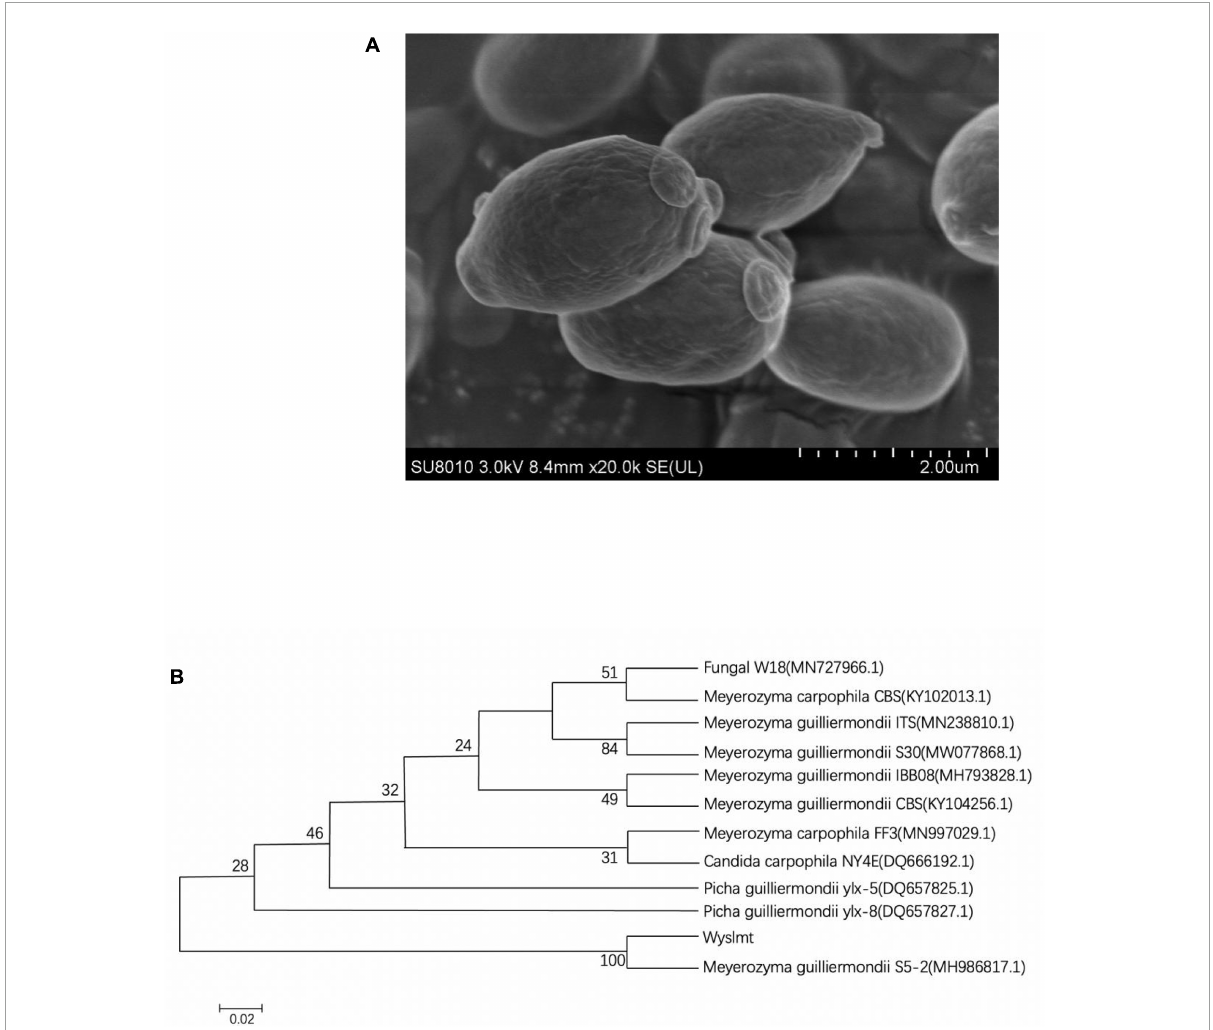
FIGURE1 Scanning electron micrograph of the Wyslmt strain (A) . Phylogenetic tree based on the 26S rDNA gene sequences from the Wyslmt yeast strain (B) . The neighbor-joining method was used to construct a phylogenetic tree (bootstrap number = 1,000), with the scale bar denoting 0.02 substitutions per nucleotide